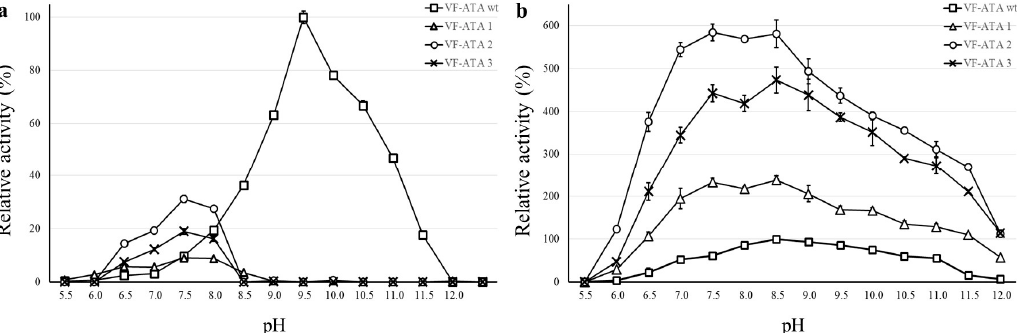
Figure 4. pH profile of the VF-ATA wild-type and variants M1–3. ( a ) pH profile using pyruvate